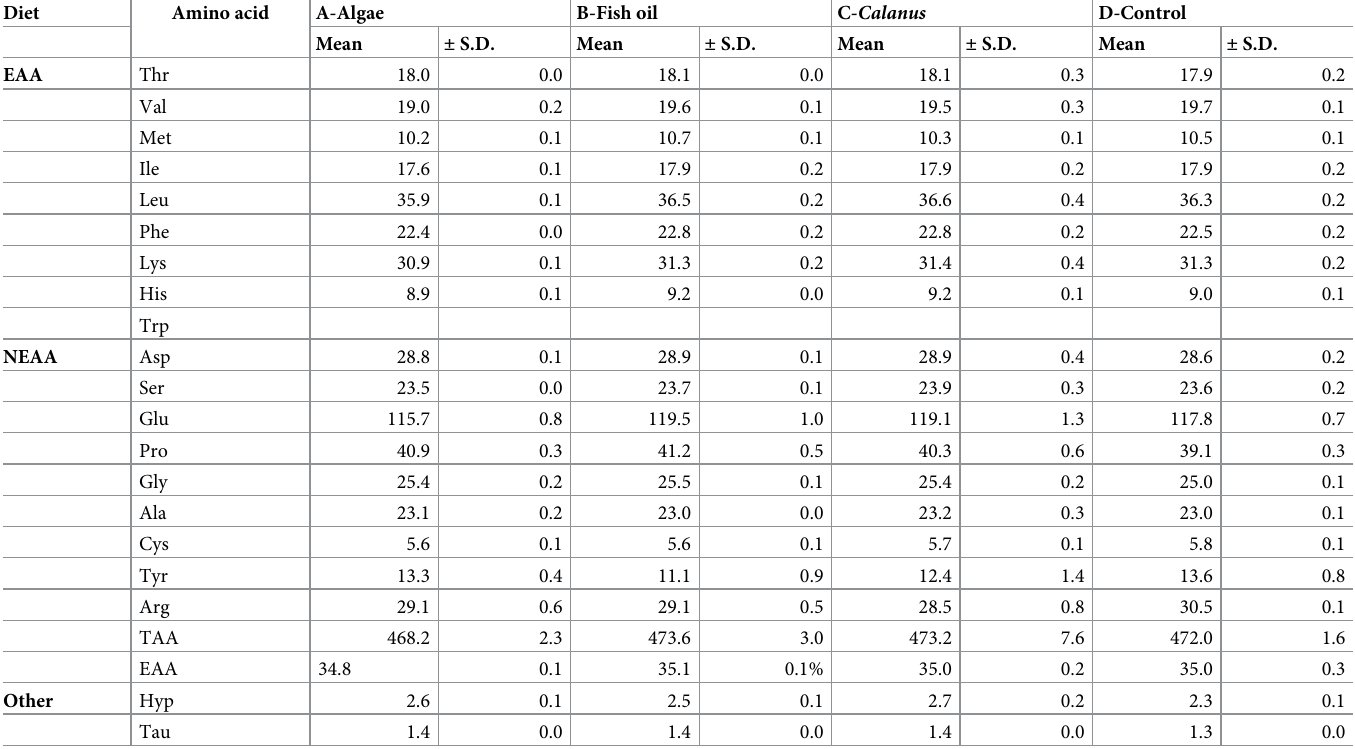
Table 6. Essential Amino acids (EAA, mg gDW -1 ), Arginine = Arg, Histidine = His, Isoleucine = Ile, Leucine = Leu, Lysine Lys, Methionine = Met, Phenylalanine = Phe, Threonine = Thr, Tryptophan = Trp, Valine = Val; Nonessential ones (NEEA): Alanine = Ala, Asparagine = Asn, Aspartic acid = Asp, Cysteine = Cys, Glycine = Gly, Glutamic acid = Glu, Glutamine = Gln, Proline = Pro, Serine = Ser, Tyrosine = Tyr, Hydroxyprolin = Hyp.Taurin = Tau, TAA = Total amino acids (sum of amino acid residues), %EAA = Essential amino acids as % of total.